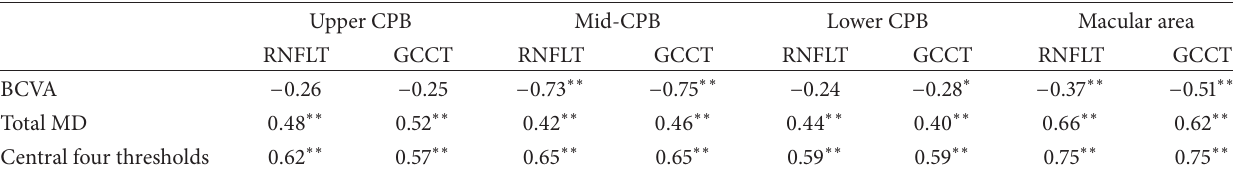
Figure2:Correlationofthecentralfourthresholdsandbest-correctedvisualacuity(BCVA)toretinalnervefiberlayerthicknessandganglion cell complex thickness in the middle central papillomacular bundle (mid-CPB) and macular area. Scatterplots of the correlation of the central four thresholds to the mid-CPB and macular thickness (a) and scatterplots of the correlation of BCVA to the mid-CPB and macular thickness (b). Table 2: Correlation of retinal thickness with visual acuity and retinal sensitivity.